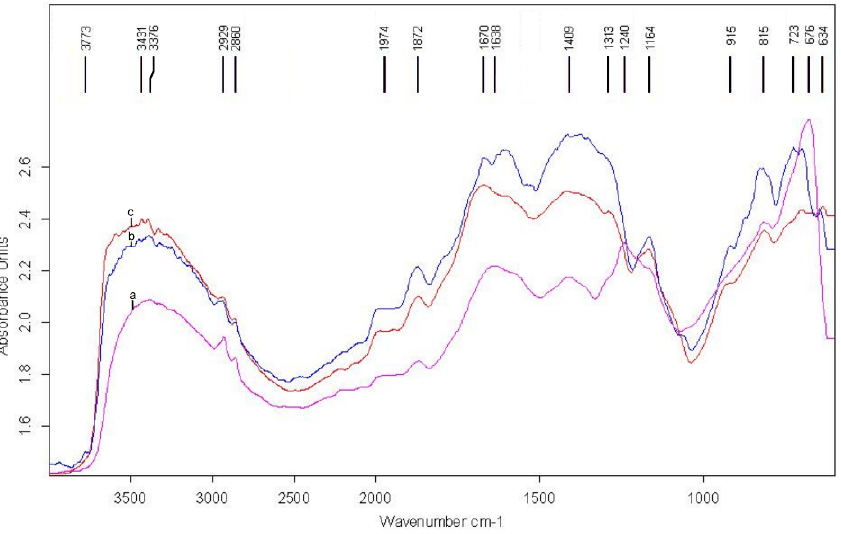
Figure 11. FT-IR spectra for sample L11 (a) ceramic paste; (b) outer surface; (c) inner surface). montmorillonite [51 ] ((Na,Ca) 0.33 (Al,Mg) 2 (Si4O10)(OH) 2 ·nH 2 O) were identified mainly by the presence of the central peak at 3376 cm − 1 , from the specific range 3300–3500 cm − 1 . In addition, the inner